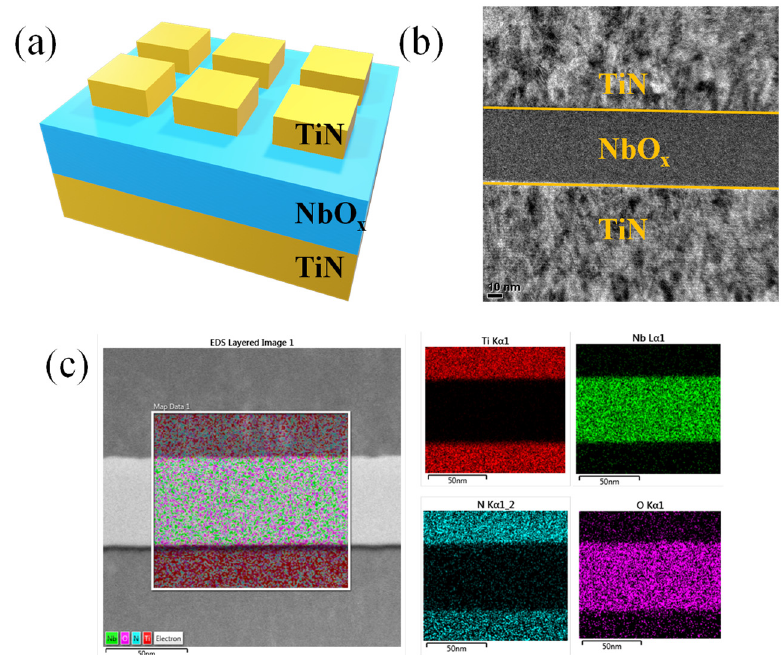
Figure 1. Stack of the TiN/NbOx/TiN device: ( a ) schematic and ( b ) TEM image. ( c ) EDS color mappings for the elements Ti, Nb, N, and O.